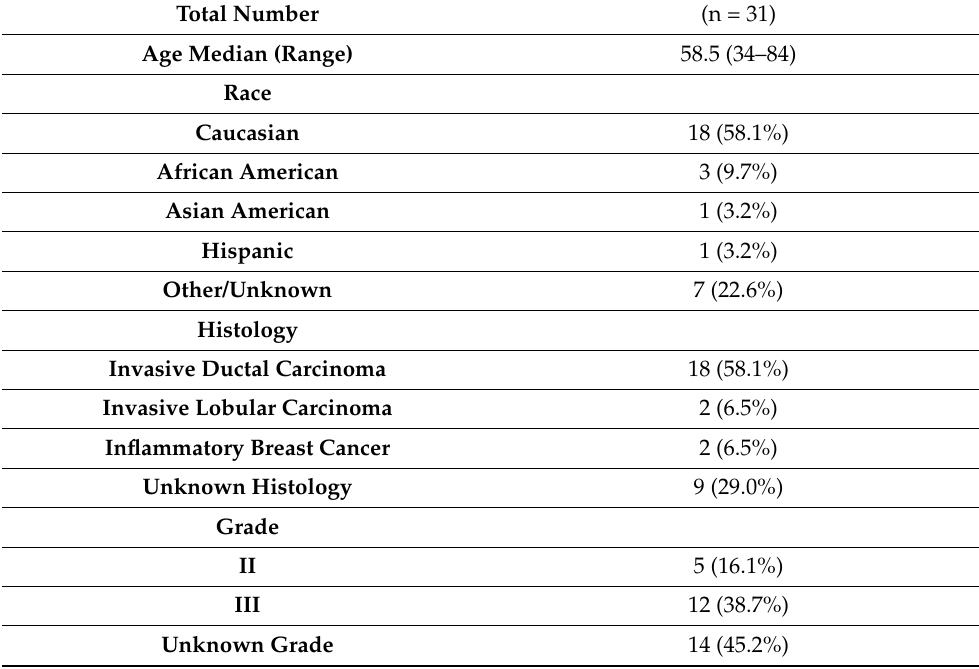
Table 1. Demographic table of the patients used in this